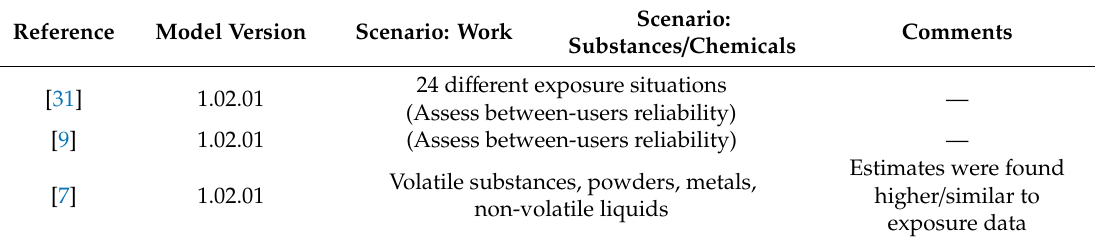
Table 7. Summary of articles concerning the MEASE model founds in the present review.